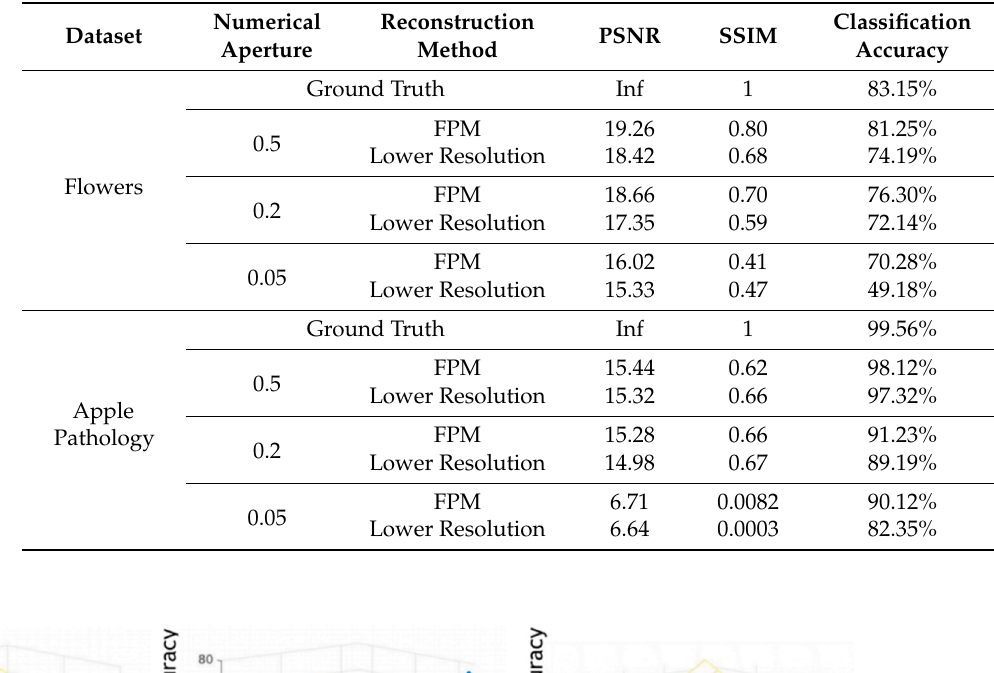
Table 3. PSNR, SSIM, and classification accuracy for flowers and apple pathology datasets.